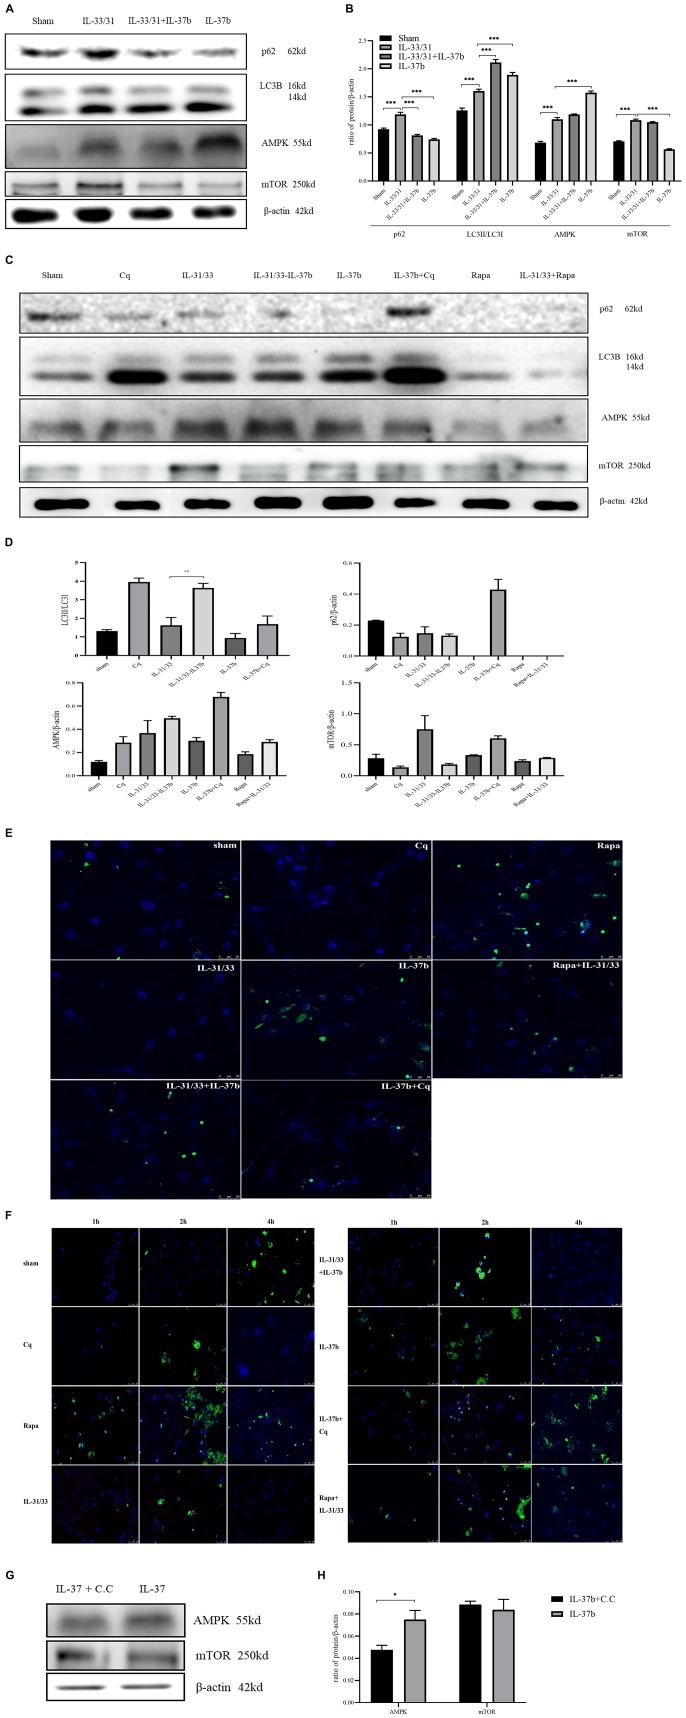
Effect of IL-37b on the induction of autophagy by analyzing the expression of p62, LC3B, AMPK and mTOR in human eosinophil-dermal fibroblast co-culture upon IL-31 (100 ng/mL) and IL-33 (100 ng/mL) stimulation. Cq: chloroquine (20 μM), autophagy negative control. Rapa: rapamycin (10 ng/mL), autophagy positive control. To verify the up-regulatory effect of IL-37b on AMPK, dorsomorphin (20 μM, Compound C/C.C), an AMPK inhibitor, together with IL-37b were applied in the co-culture. (A) Western blots analysis and (B) Quantification of AMPK, mTOR, p62 levels normalized to β-actin and LC3II/LC3I ratio (100 ng/mL IL-37b treatment for 24 h). (C) Western blot analysis. The Cq band for β-actin has been spliced from the same gel, due to an experimental error. Please see the Supplementary Material for the original blot image. (D) Quantification of AMPK, mTOR, p62 levels normalized to β-actin and LC3II/LC3I ratio in co-culture treated with IL-31, IL-33, and IL-37b (100 ng/mL), chloroquine and rapamycin treatment for 16 h. (E) Representative images of LC3 puncta (green) in co-culture treated with IL-31, IL-33, and IL-37b (100 ng/mL), chloroquine and rapamycin treatment for 16 h. (F) Representative images of LC3 puncta (green) in co-culture treated with IL-31, IL-33, and IL-37b (100 ng/mL), chloroquine and rapamycin treatment for 1, 2, and 4 h. Nuclei were visualized by DAPI (blue) staining. (G) Western blot analysis. (H) Quantification of AMPK and mTOR levels normalized to β-actin in co-culture treated with Compound C and IL-37b for 16 h. Chloroquine (Cq) pretreatment for 60 m prior to IL-37b treatment; rapamycin (Rapa) pretreatment for 10 m prior to IL-31 and IL-33 treatment. Bar charts are shown as mean ± SEM of triplicate independent experiments. *P < 0.05, **P < 0.01, and ***P < 0.001 when compared between the denoted groups.